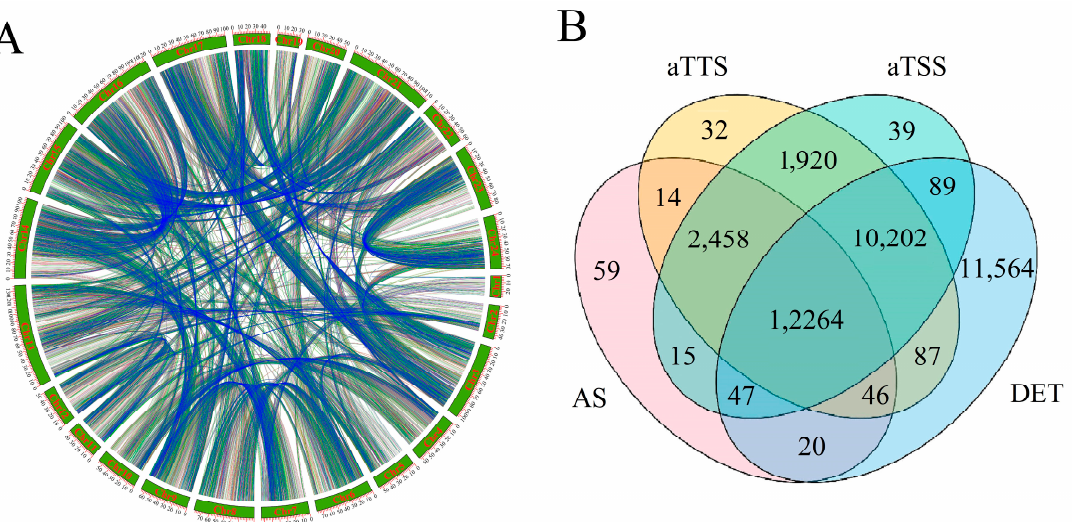
Figure 6. The relationship between gene structures and the number of isoforms per gene. ( A ) Exon length. ( B ) mRNA. ( C ) Exon number. ( D ) GC content.